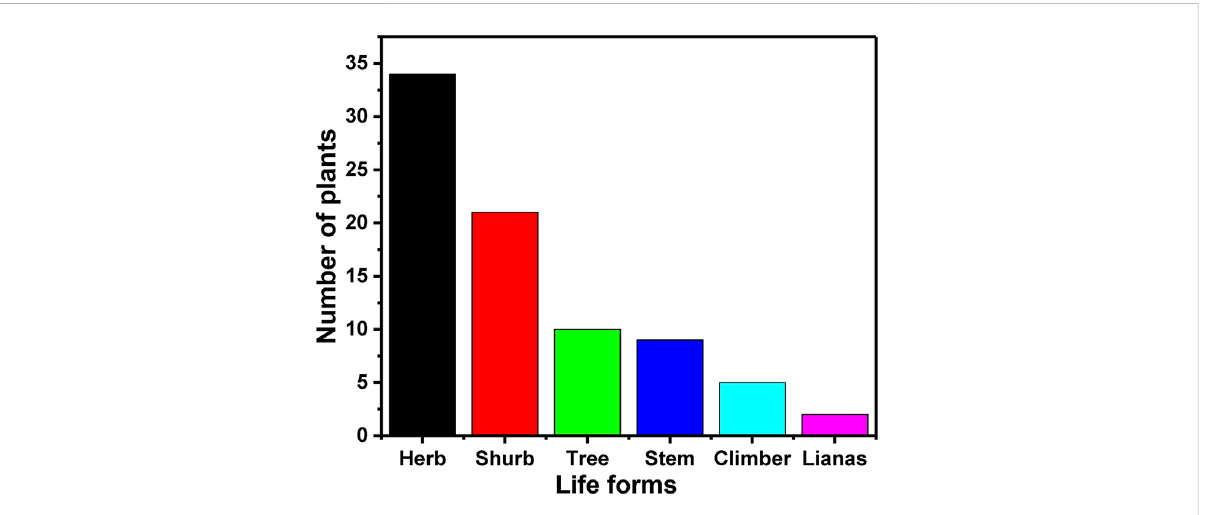
FIGURE 4 Life forms of the medicinal plants. The fi gure depicts the number of different plants categorised into different life forms used by the traditional healers at Gullele Botanical Garden for preparing the traditional medicine.